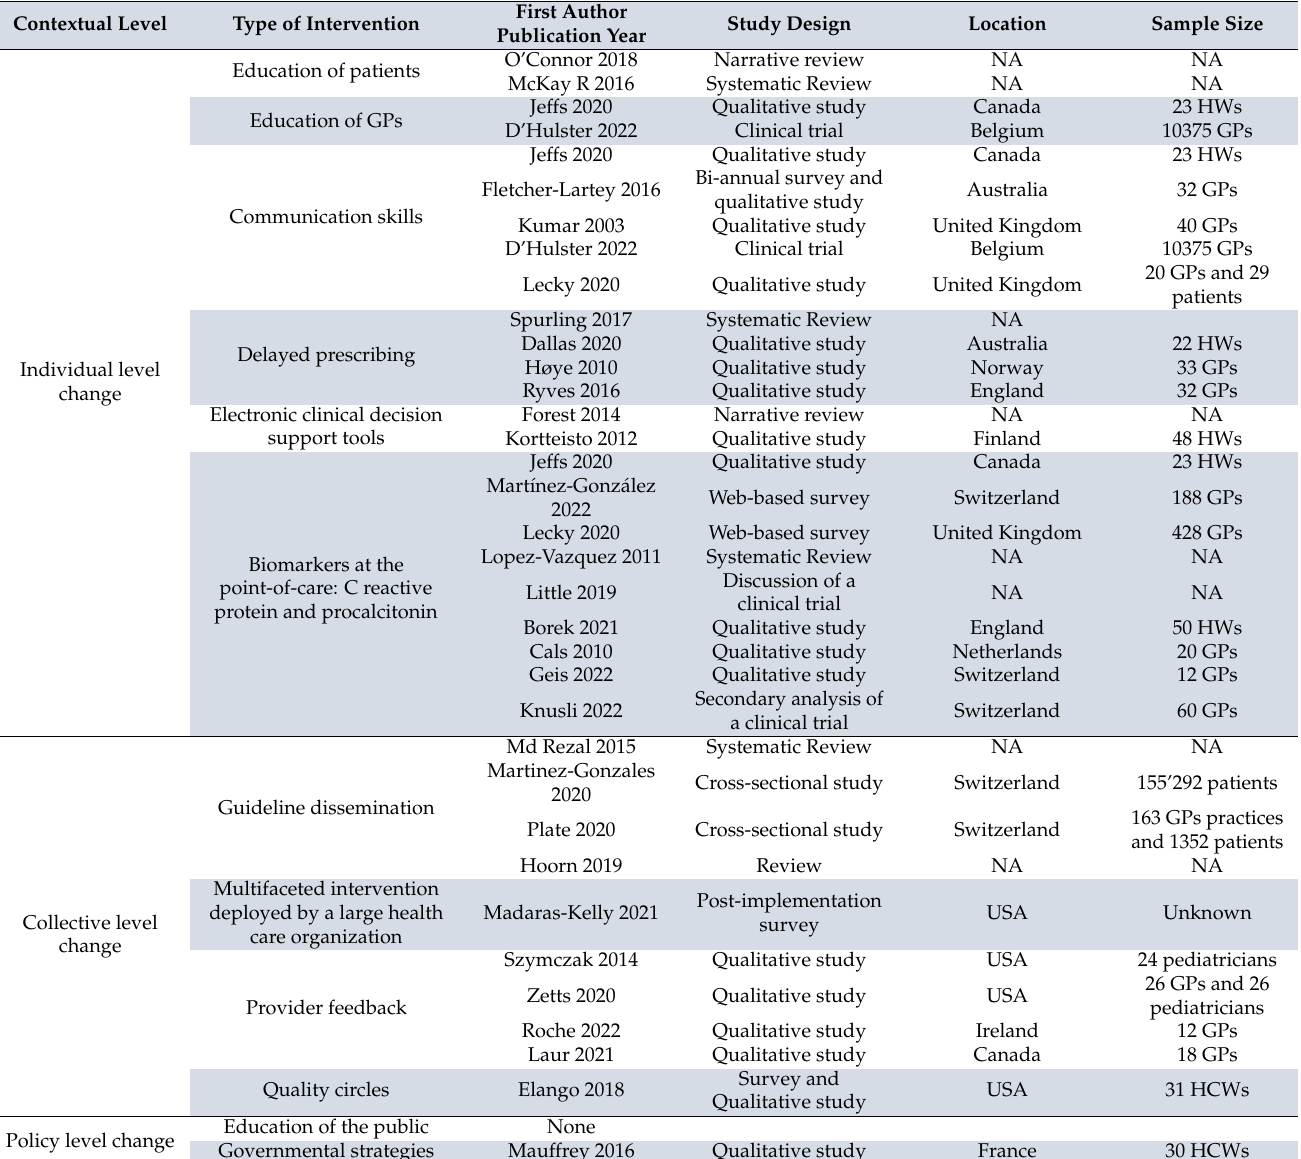
Table 1. Characteristics of studies on factors influencing the implementation of antimicrobial stew- ardship activities and categorized according to different contextual